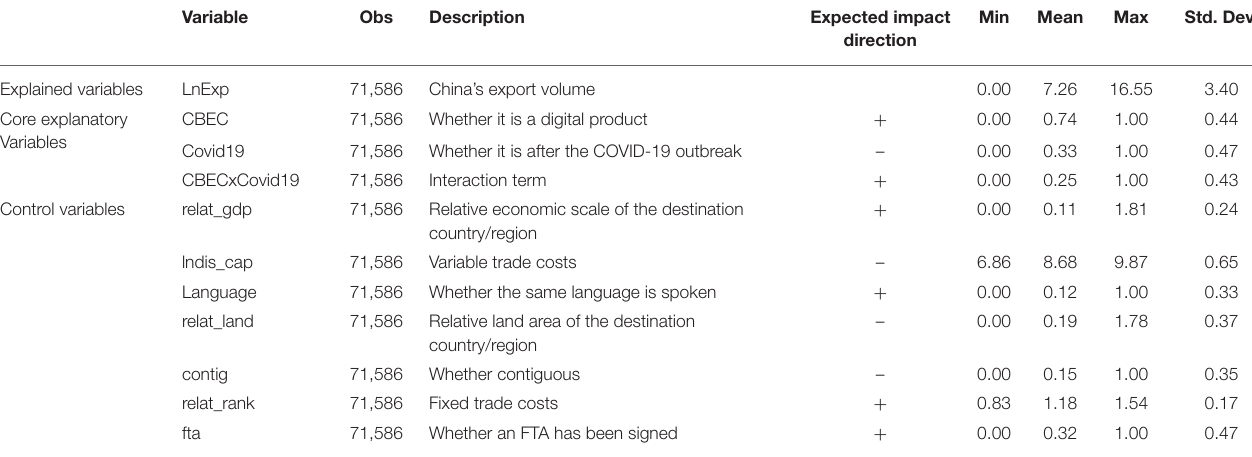
TABLE 1 | Descriptive statistics of the